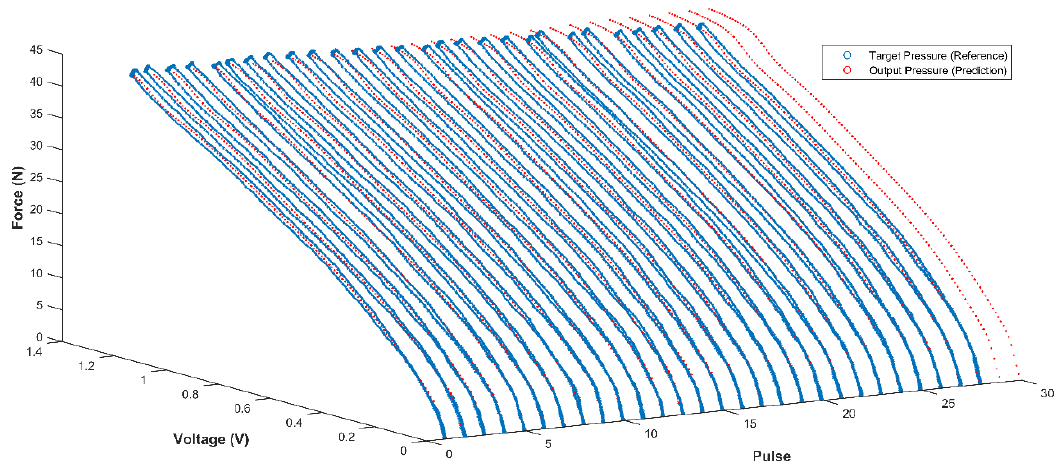
Figure 9. Output trained network performance versus the target (reference) for 20 min onward using untrained data set input.